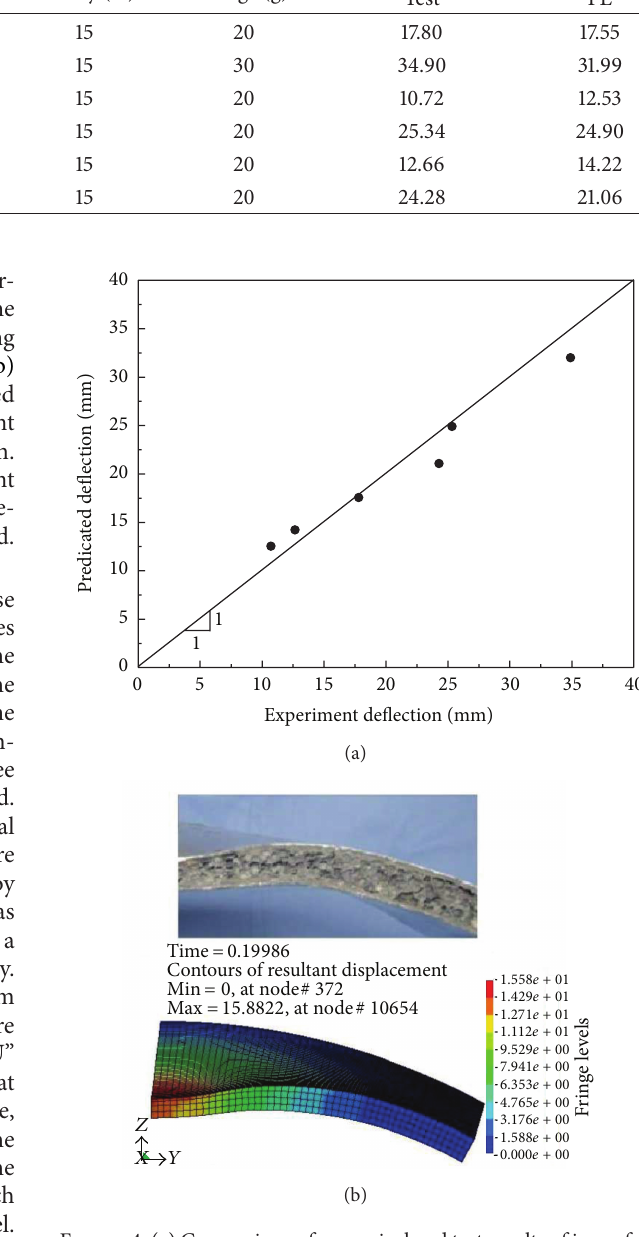
Figure 4: (a) Comparison of numerical and test results of inner face central deflections and (b) tested and simulated panel deformation and simulated resultant displacement contour of specimen 1 in Table 3 at 2000 𝜇 s after